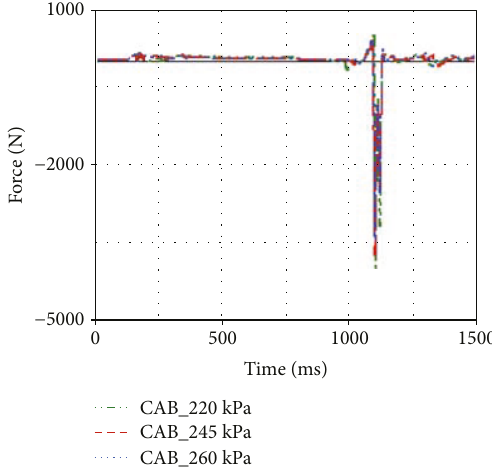
Figure 17: Upper neck F